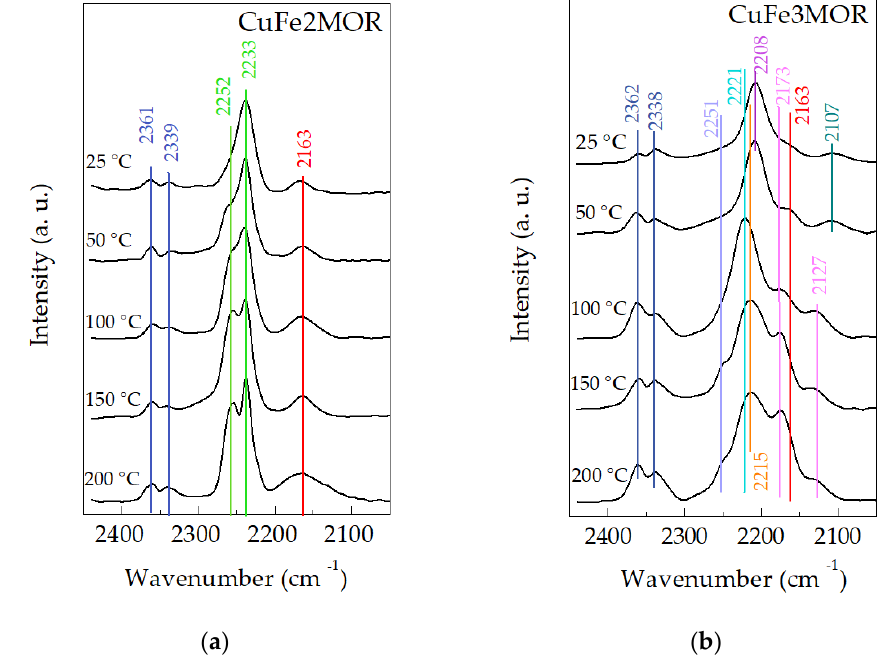
Figure 7. DRIFT spectra of adsorbed CO for CuFe2MOR ( a ) and CuFe3MOR ( b ).